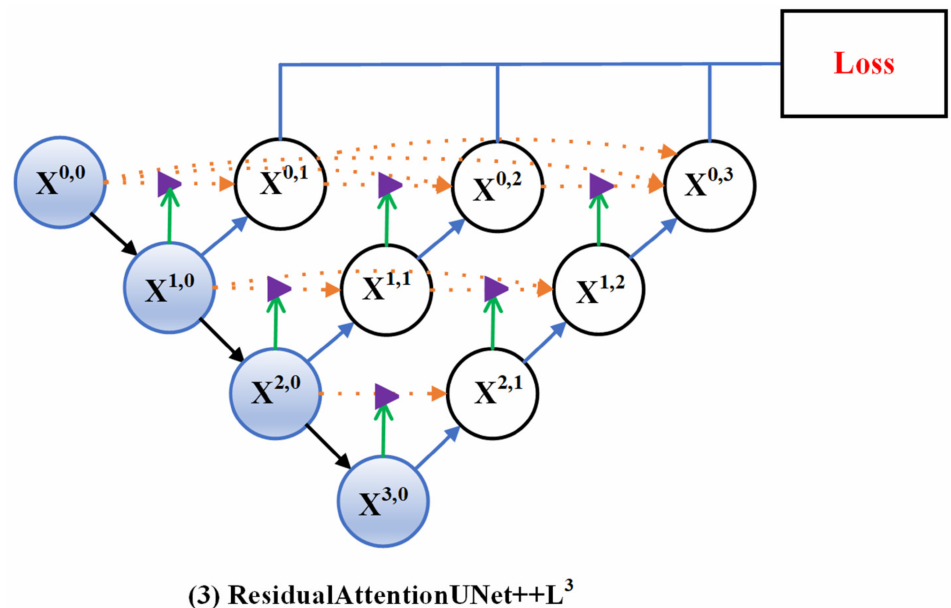
Figure 8. Residual-Attention UNet++ can be pruned to Residual-Attention UNet++ L 3 if trained with deep supervision.